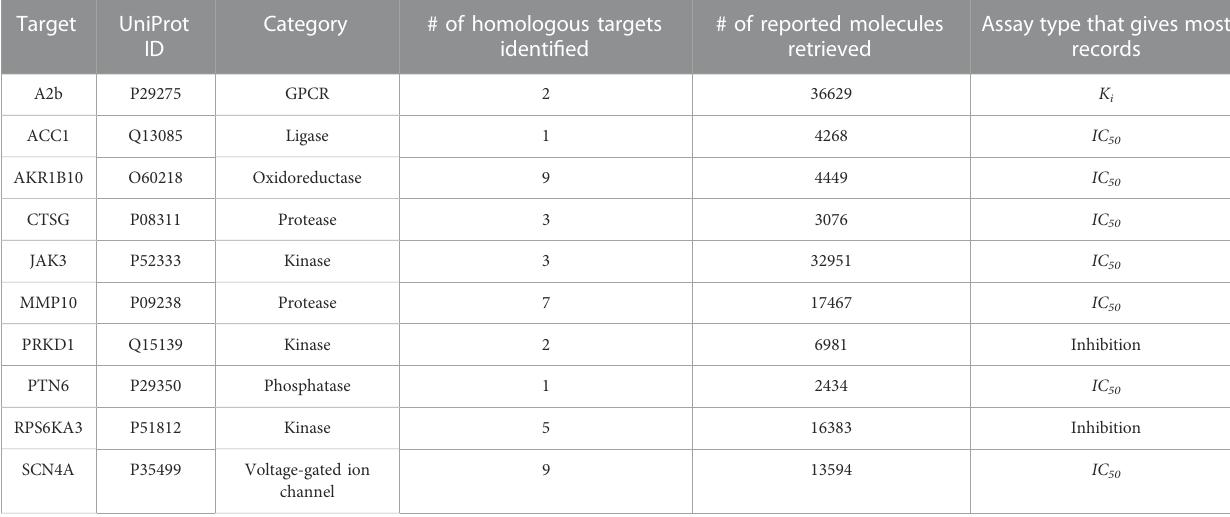
TABLE 1 Ten protein targets in retrospective